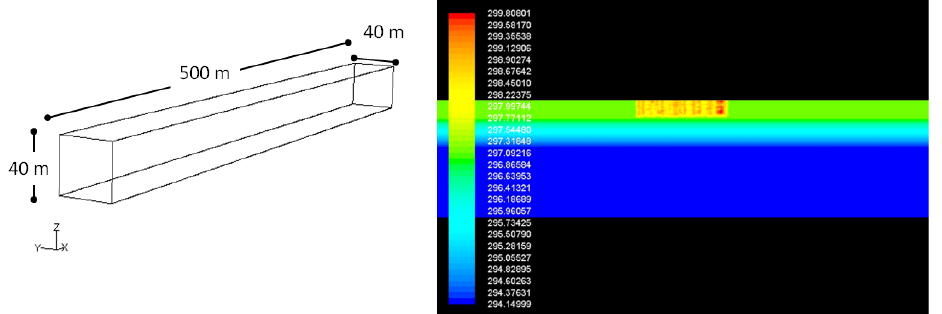
Figure 5. Model domain (left) and side view of initial condition in the temperature field (right; at t = 0s, in kelvin) for the low-density plume simulation. Model horizontal resolution is 0.5m in x by 1m in y and vertical resolution is 1cm at the top (with decreasing vertical resolution towards the bottom).